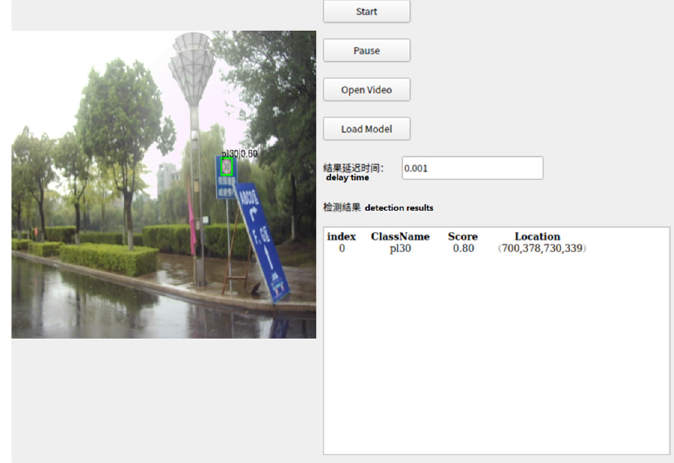
Figure 17. Image display interface.